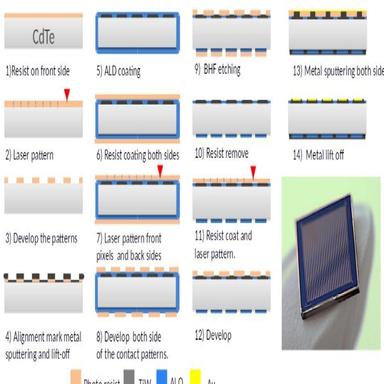
Schematic of the processing steps (cf.).